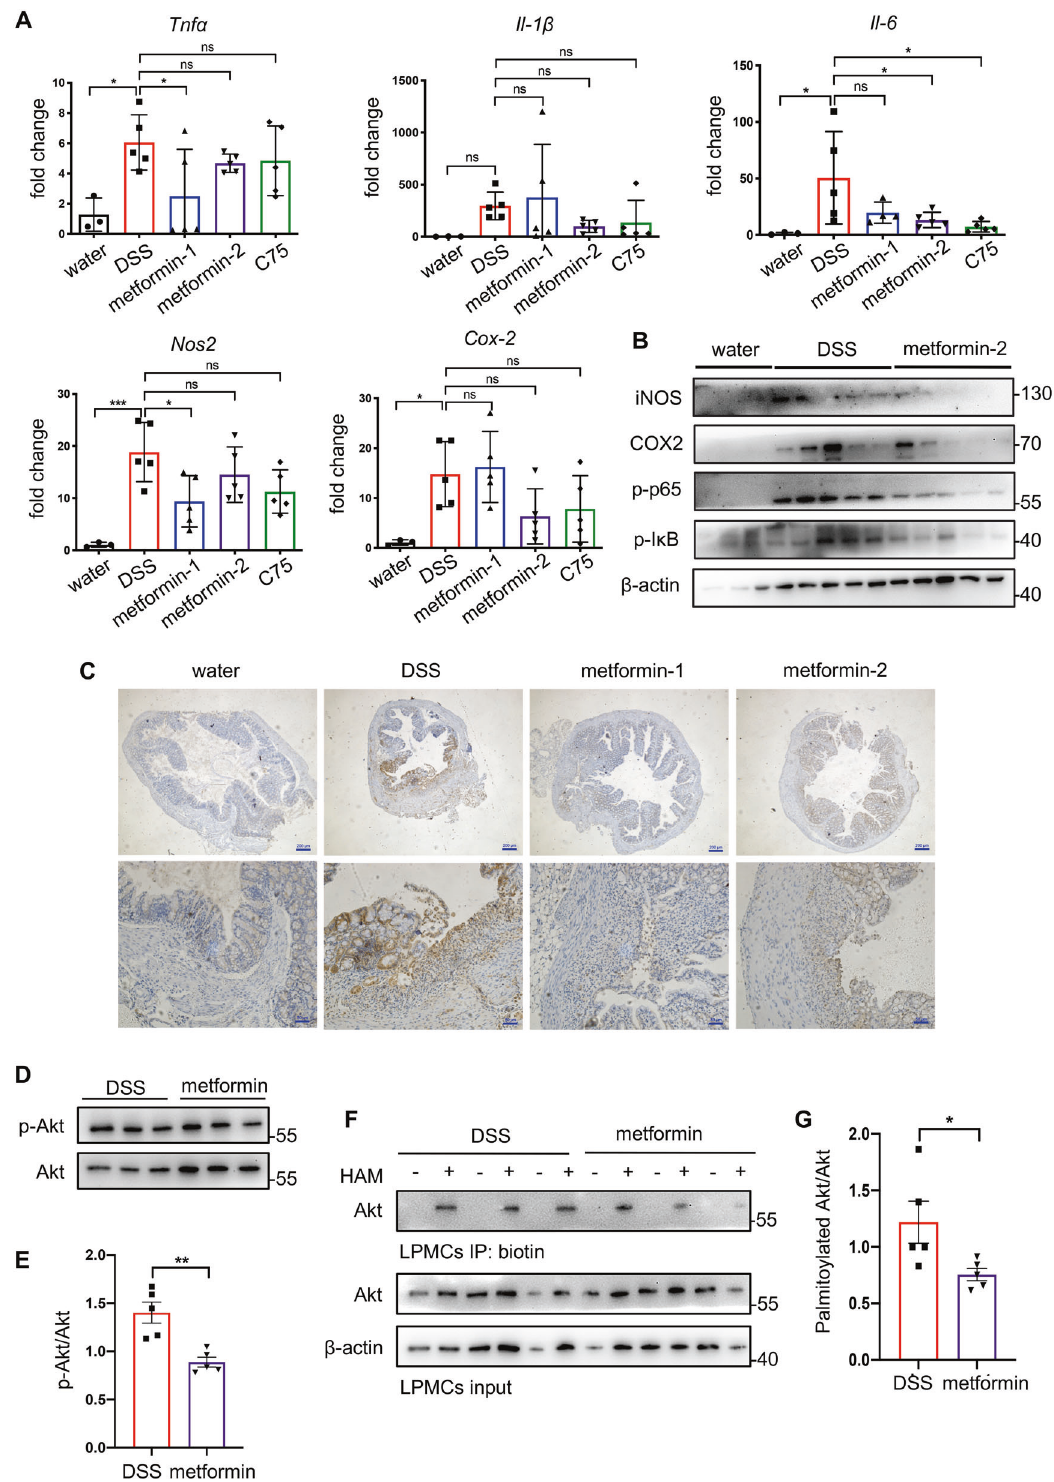
Fig. 8 Metformin suppressed proin fl ammatory responses of colonic LPMCs in DSS-induced colitis mice. Murine lamina propria mononuclear cells (LPMCs) were isolated from colons on day 8. A The mRNA levels of Tnf α , Il-1 β , Il-6 , Cox-2 , and Nos2 in LPMCs were determined by qRT-PCR. B Proin fl ammatory proteins in LPMCs were determined by Western blotting. C The expression of TNF α in colons was detected by immunohistochemistry. D , E The phosphorylation of Akt was inhibited by metformin in colonic LPMCs. Representative images of western blotting ( D ) and quanti fi cation of p-Akt/Akt ratios ( E ). F , G The palmitoylation of Akt in colonic LPMCs was detected by the ABE method. Representative images of western blotting ( F ) and quanti fi cation of palmitoylated Akt/Akt ratios ( G ). Data were represented as means ± SD. * p < 0.05, ** p < 0.01, *** p < 0.001, **** p < 0.0001, ANOVA or t -test.